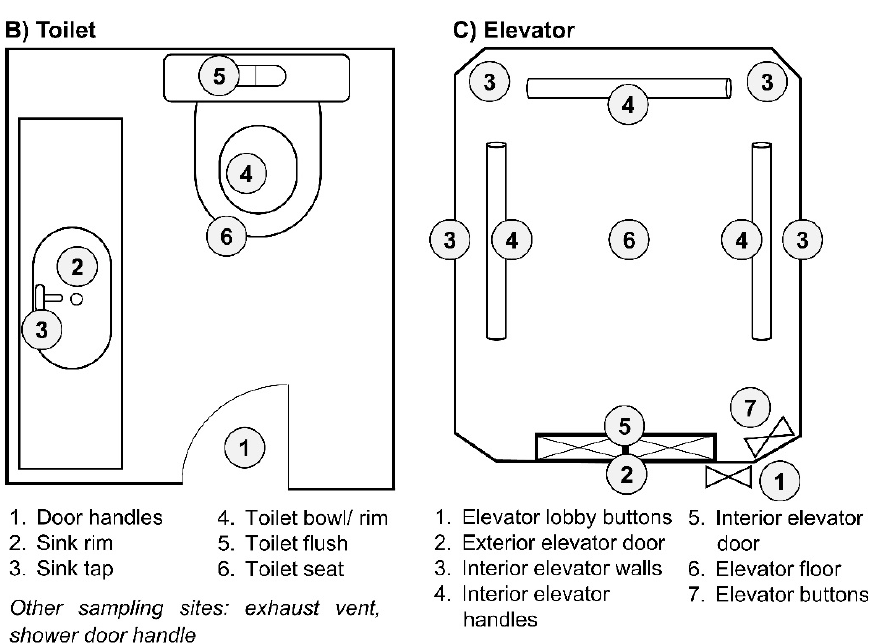
Figure 1. Sampling plan in each type of location. Representative sampling sites for ( A ) accommo- dation rooms, ( B ) toilets and ( C ) elevators. Environmental swab samples were taken at the areas indicated in numbers.